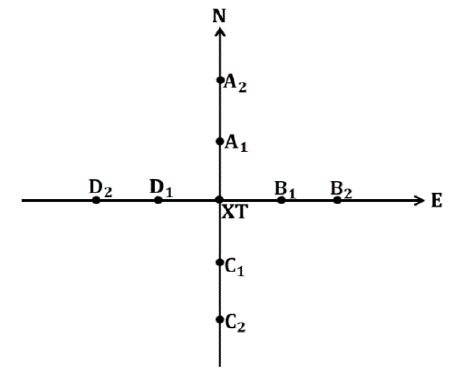
Figure 9. Distribution of Points for calculating the deflections of the vertical components.